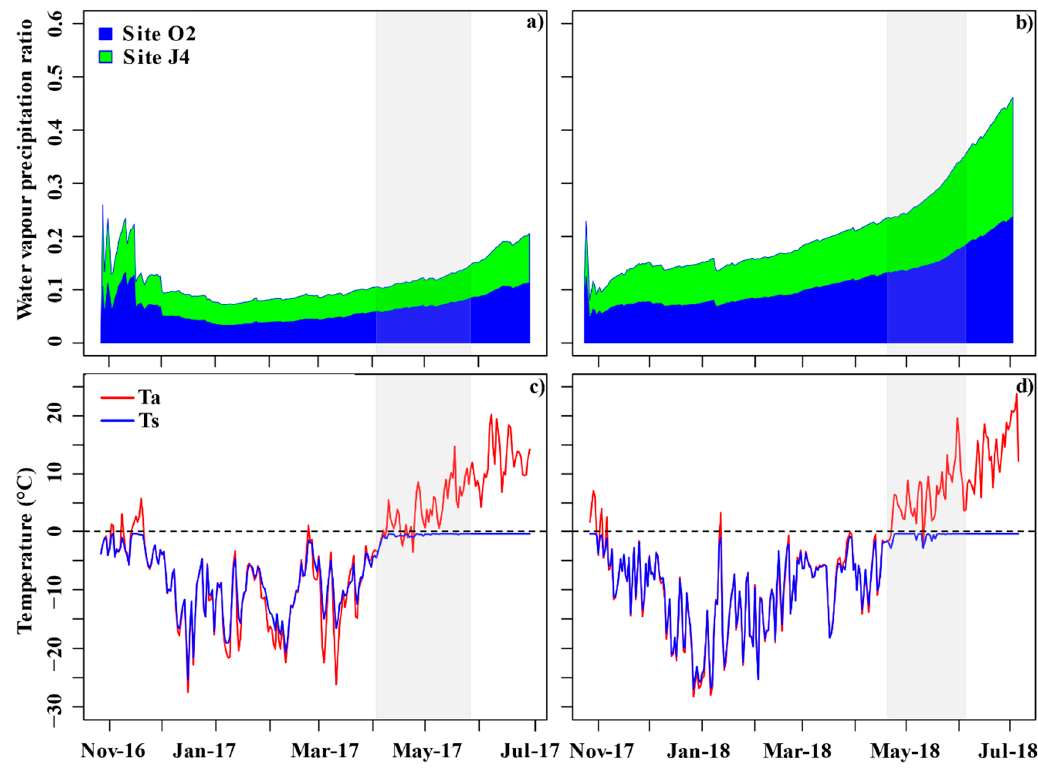
Figure 6. Importance of some relevant inputs: water vapour losses to precipitation ratio at daily time steps ( a ) for the first winter (W1) ( b ) for the second winter (W2) ( c ) Air (T a ) and snow surface (T s ) temperature (all sites averaged) at daily time steps ( c ) for the first winter (W1) and ( d ) air (T a ) for the second winter (W2). In the above plot, the shaded region represents the ablation period and to its left is the accumulation period.